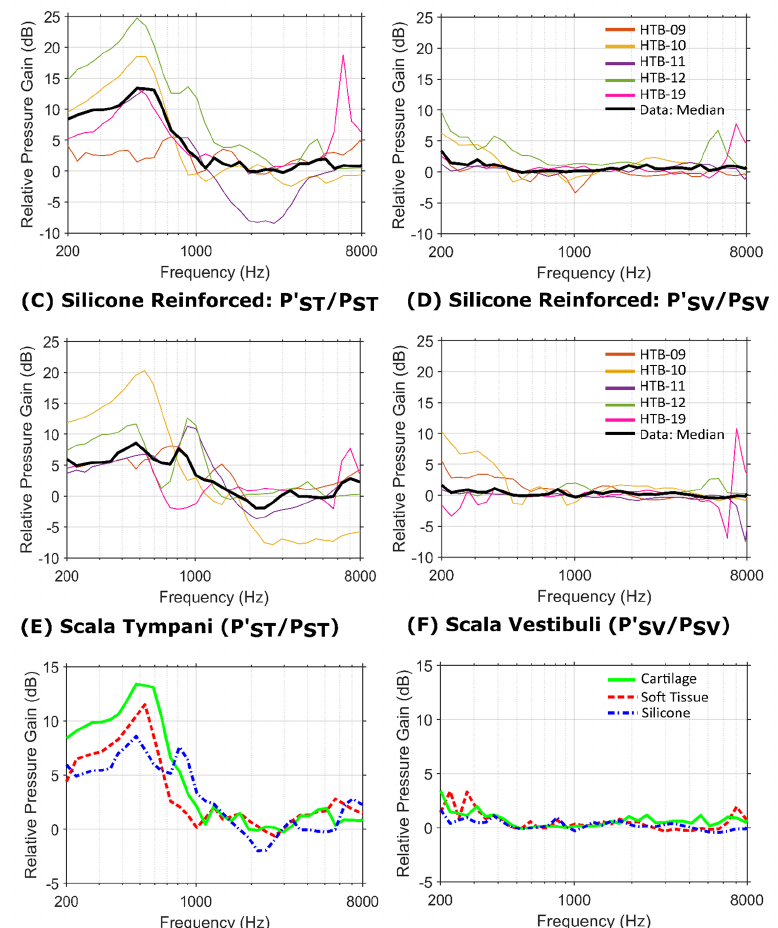
Figure 6. Relative pressure gain in ST and SV observed after the RWM reinforcement with cartilage and silicone ( A – D ). Median values are represented as a solid black line. ( E , F ) represent the median relative pressure gain values for all three materials, ( E ) ST, and ( F )